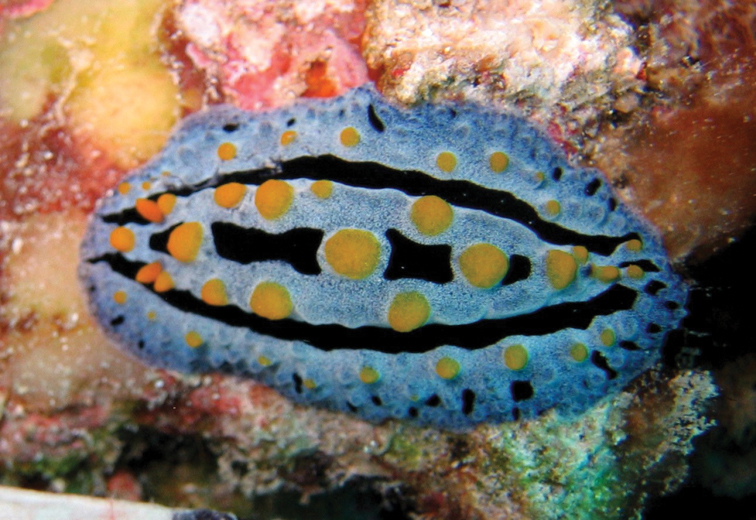
Phyllidia coelestis, Tanzania, photo: A de Villiers (no spcm).